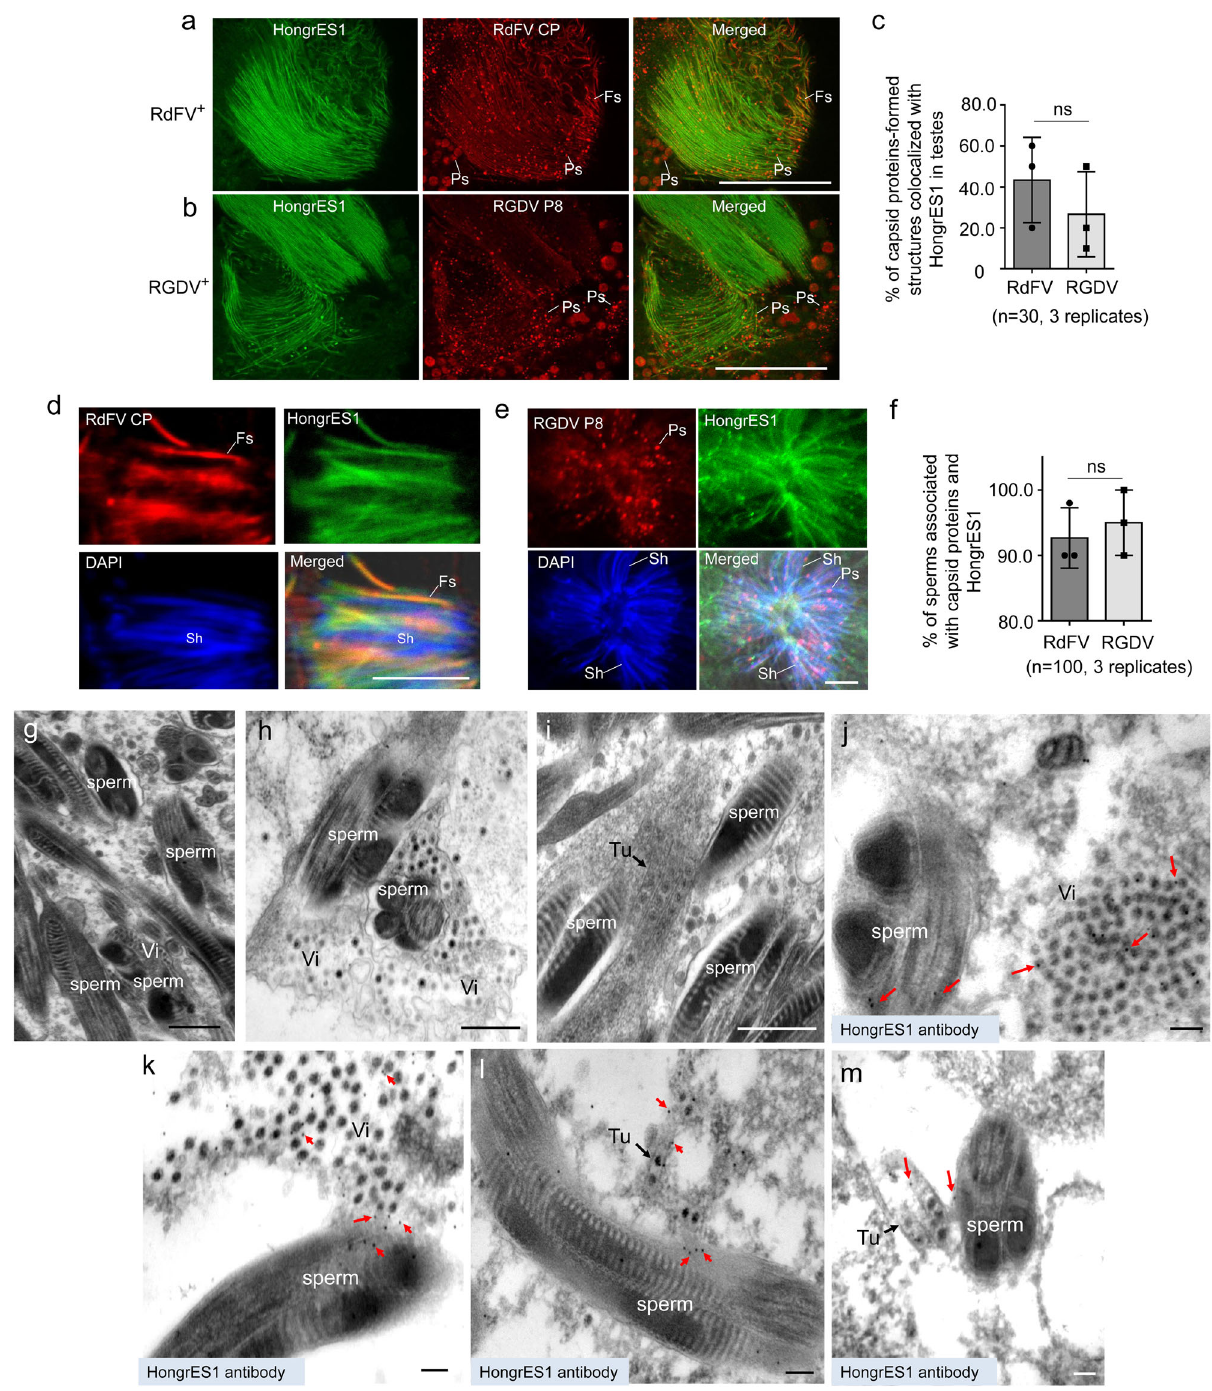
Fig. 3 | Direct association of RdFV CP or RGDV P8 with HongrES1 on sperms in infectedtestesofmale R.dorsalis . AssociationofRdFVCP( a )orRGDVP8( b )with HongrES1,asdetermined by immuno fl uorecense microscopy.The dissectedtestes from 30 RdFV- or RGDV-positive males were immunostained with HongrES1-FITC (green) and CP-rhodamine (red) ( a ), or with HongrES1-FITC (green) and P8- rhodamine (red) ( b ).Ps, punctate structure. Fs, fi lamentous structure. Bars, 10 μ m. c Themeanpercentagesof CP-orP8-formed structurescolocalized withHongrES1 in respective infected testes ( n =30). Means (±SD) represent three biological replicates(two-tailedt-test).Ns,notsigni fi cant.AssociationofRdFVCPorRGDVP8 with HongeES1 on the dissected sperms, as determined by immuno fl uorecense microscopy. The dissected sperms from 30 RdFV- or RGDV-positive testes were stained with HongrES1-FITC (green), CP-rhodamine (red) and nuclear dye DAPI